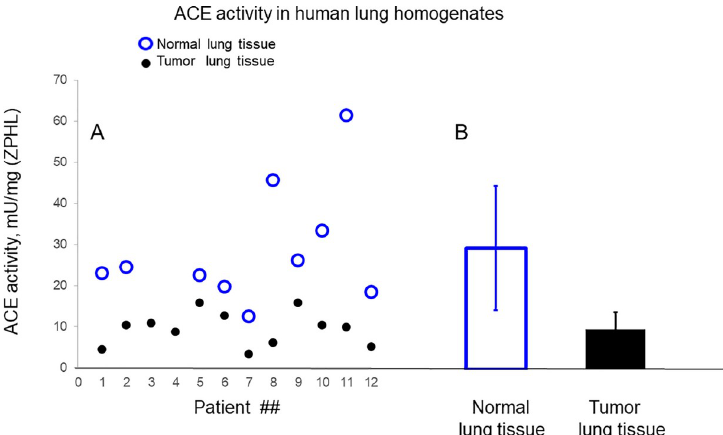
Fig 3. ACE activity in lung cancer tissues. ACE activity in 12 homogenates (1:9 weight/volume ratio) of human lung cancer tissues (black dots) and in 10 homogenates from morphologically normal lung tissues (used as controls), (blue circles) was quantified using a spectrofluorometric assay with Z-Phe-His-Leu (2 mM) as substrates. Data expressed as individual values in mU/mg of protein (black dots and blue circles in A) and as mean values for control (blue bar- 28.6 ± 14.6 mU/mg) and for tumor lung tissue (9.4 ± 3.2 mU/mg). Data presented as a mean of at least 3 independent experiments (with intra-assay SD <